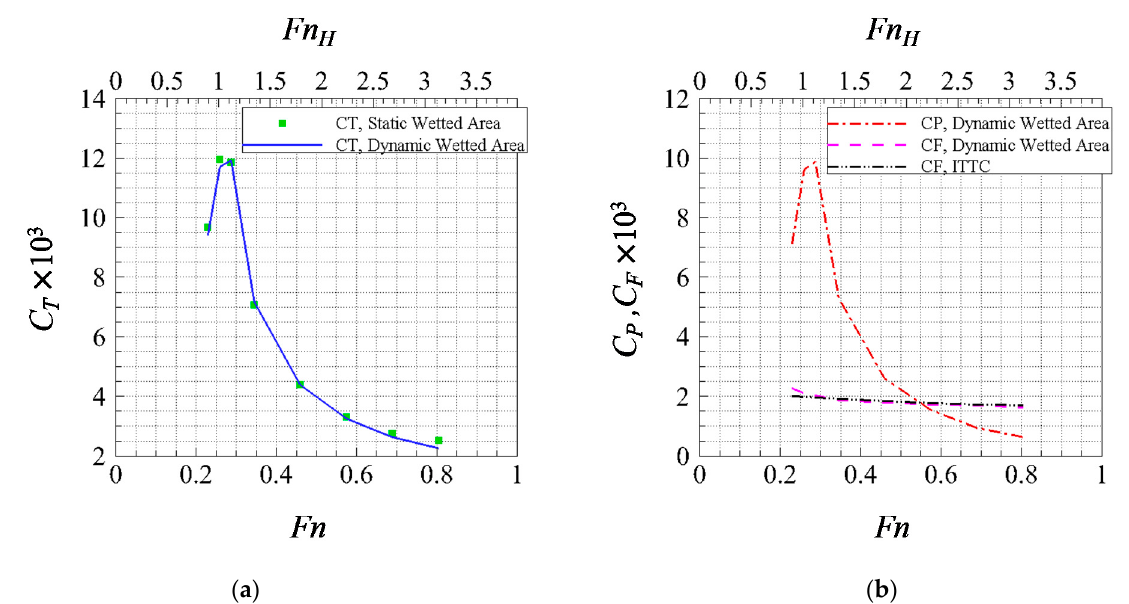
Figure 11. Total resistance coefficient ( a ), and pressure and frictional resistance coefficients ( b ) of the London Demonstrator